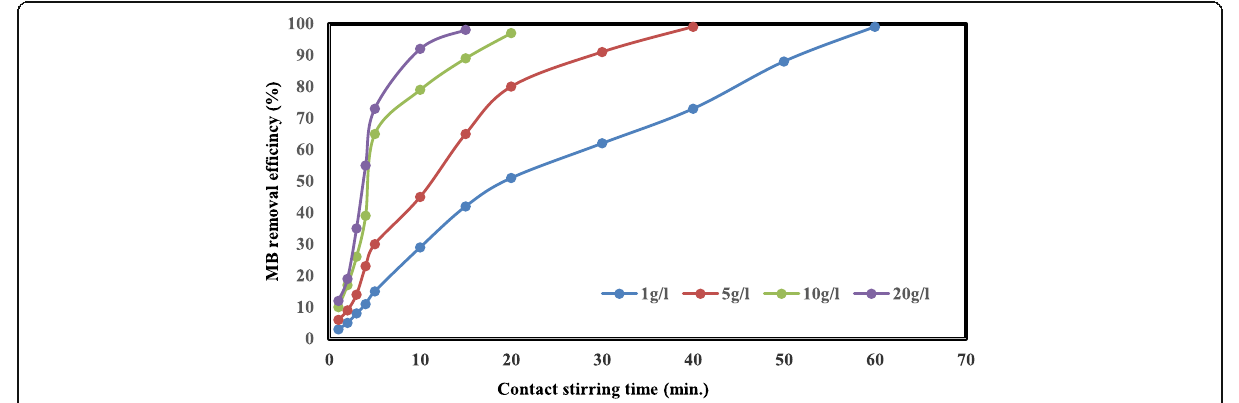
Fig. 9 Effect of contact stirring time on MB removal efficiency at different doses of NGOCB. (MB 100 mg/l, pH 7 at RT)